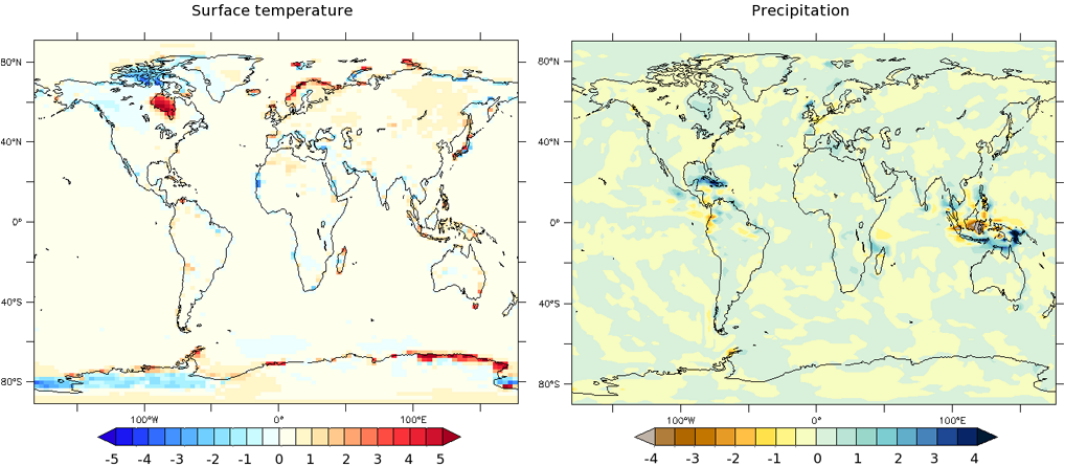
Fig. 13. Surface temperature difference between the “preferred” AGCM simulation and the “alternate” AGCM simulation, i.e. Plio1 pref minus Plio1 alt, expressed in degrees Celsius (left) and total precipitation difference (Plio1 pref minus Plio1 alt) expressed inmmday − 1